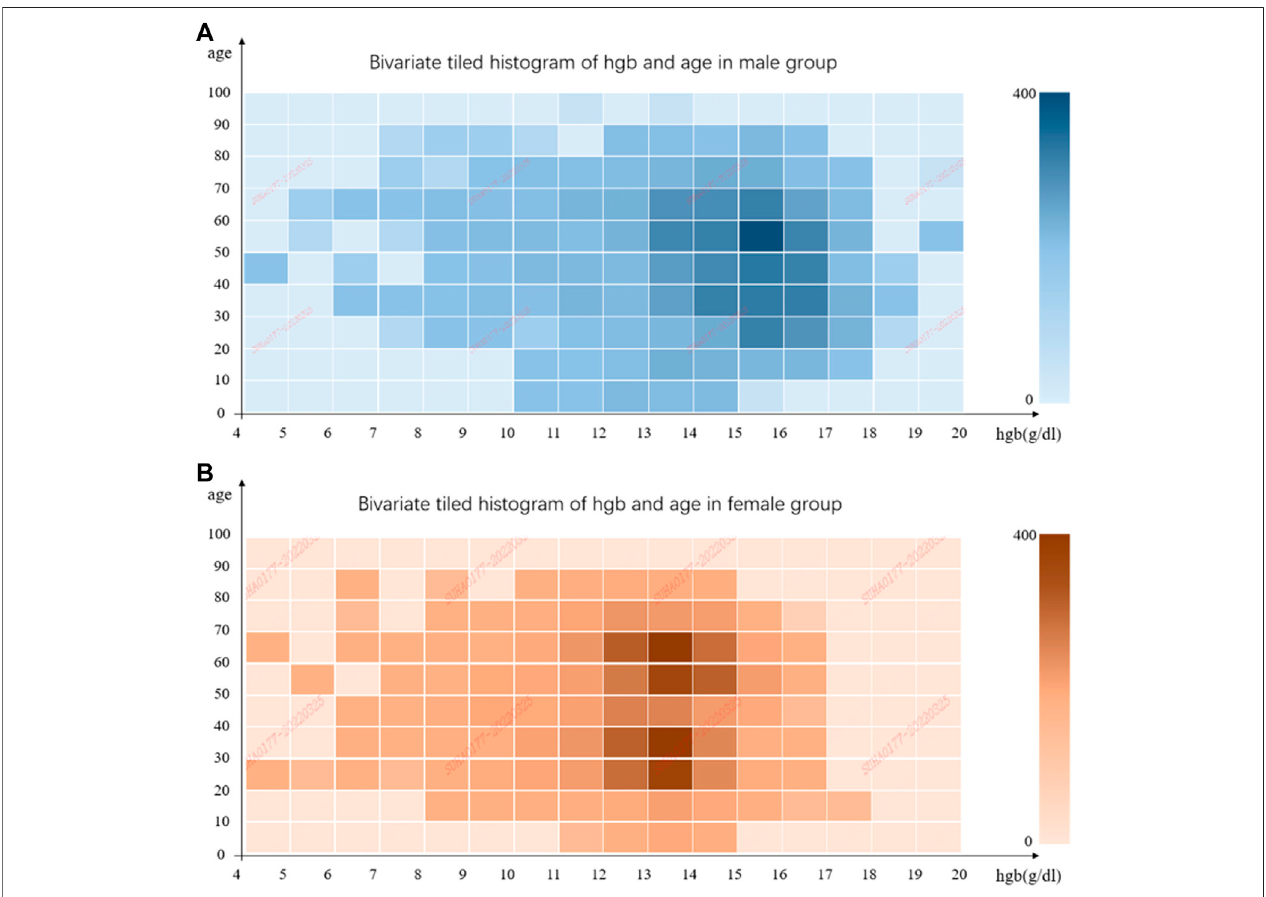
FIGURE3| Bivariatetiledhistogramsofhemoglobinconcentrationandageinmaleandfemalegroups. (A) isformaleand (B) isforfemale.Theabscissarepresents hemoglobinconcentration,andtheordinaterepresentsage.Eachbincovers1 g/dlatthehorizontalcoordinate,and10 yearsoldattheverticalcoordinate,andthecolor of bins indicates the number of elements in